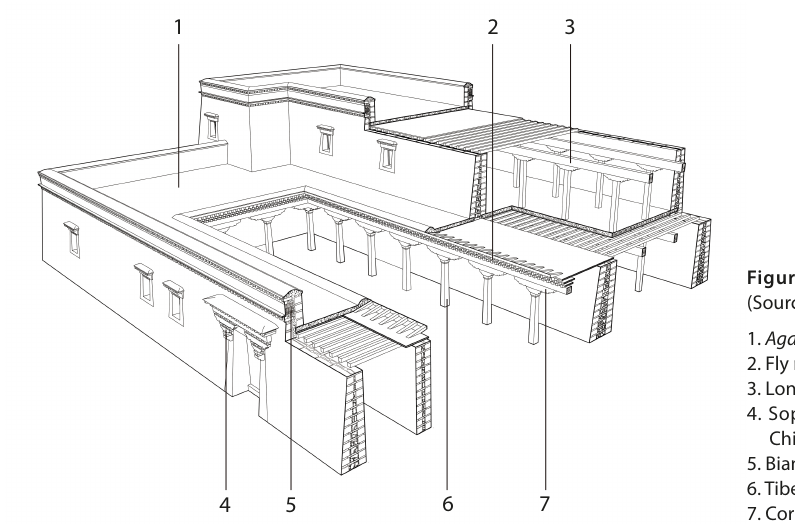
Figure 1 Illustration of typical Tibetan blockhouse (Source: Chang Qing Studio) 1. Aga clay flattop paving; 2. Fly rafter; 3. Longitudinal plane ribbed structure; 4. Sopraporta: cornice, which is a combination of Chinese brackets and Tibetan corbels; 5. Bianma wall; 6. Tibetan Column; 7.